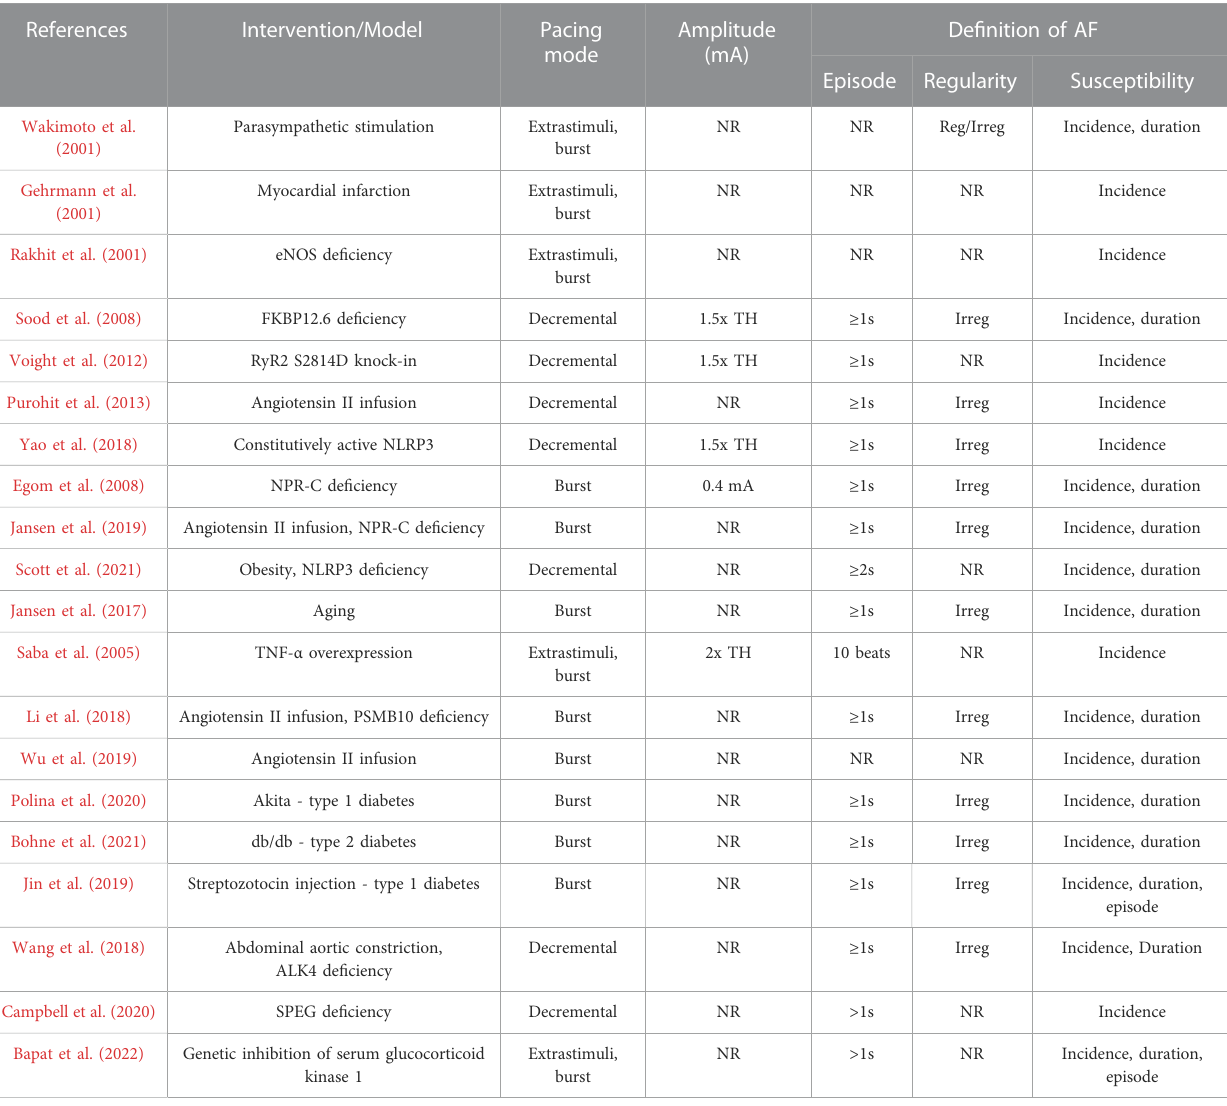
TABLE 1 Selected studies utilizing intracardiac PES to induce